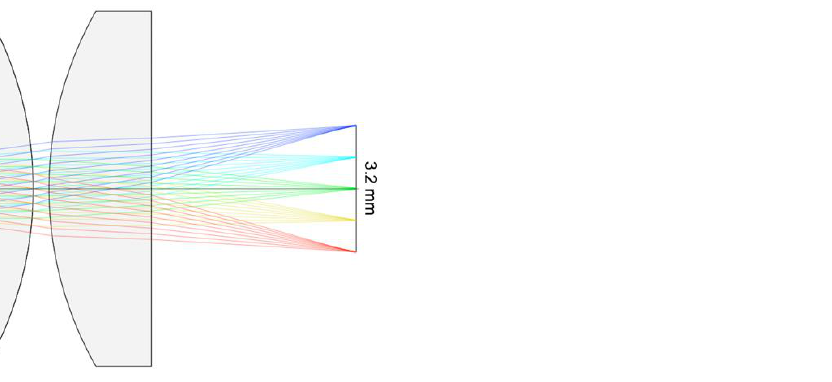
Figure 4. Ray-tracing model of the light path through the SWIR camera. The sensor array surface is represented by the thin vertical line on the right side. The red, yellow, green, teal and blue lines represent light incident on the lens surface at −13°, −6.5°, 0°, 6.5° and 13°, respectively. As shown, these rays are sharply focused on the sensor array surface except at the edges, with a linear image aberration less than 1.5%.